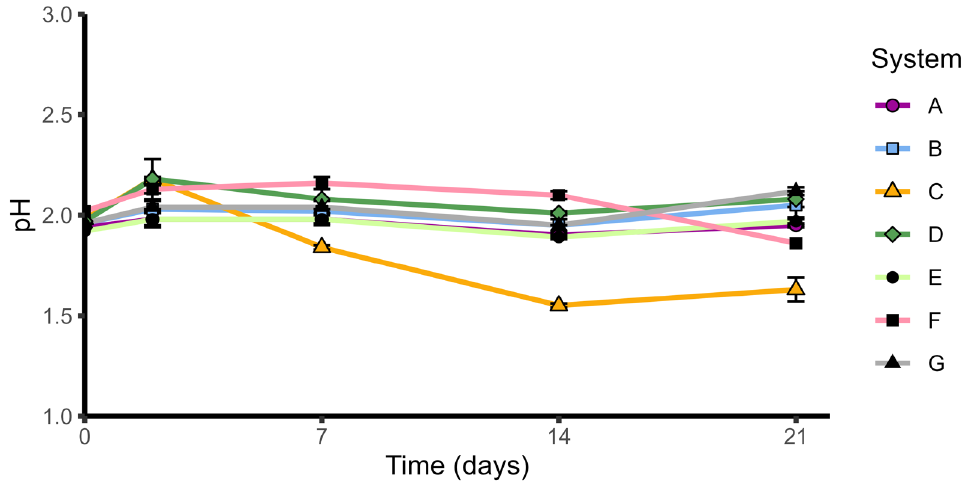
Figure 5. Evolution of pH values during bioleaching tests at 30 °C with the native consortium. Bioleaching systems ( A )–( D ) were performed with inoculation, in MAC medium with ( C ) and without ferrous iron and sulfur addition ( D ), in distilled water ( A ) or Taca Taca groundwater ( D ) with initial pH adjusted to 2.0. Systems ( E )–( G ) correspond to non-inoculated assays, performed in MAC medium, with ( F ) and without ferrous iron and sulfur supplementation ( E ) or with sterilized mineral and paraformaldehyde ( G ).